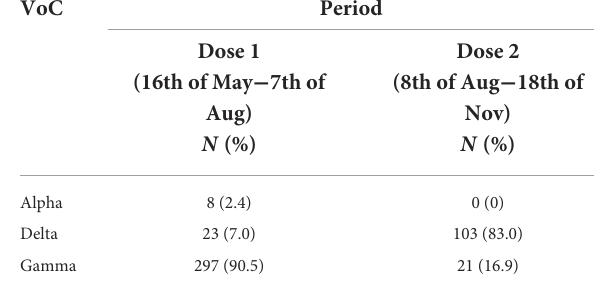
TABLE 1 Baseline characteristics of persons 18–60 years old tested for COVID-19.